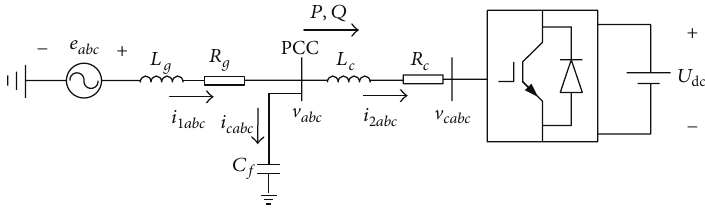
Figure 1: The benchmark test model of VSC connected to weak AC